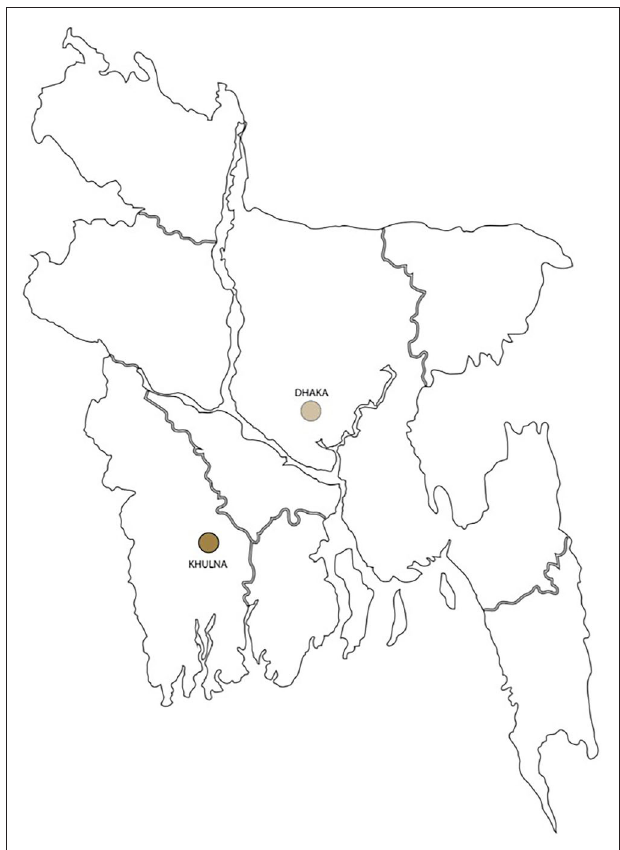
FIGURE 3 | Location map of Khulna city in